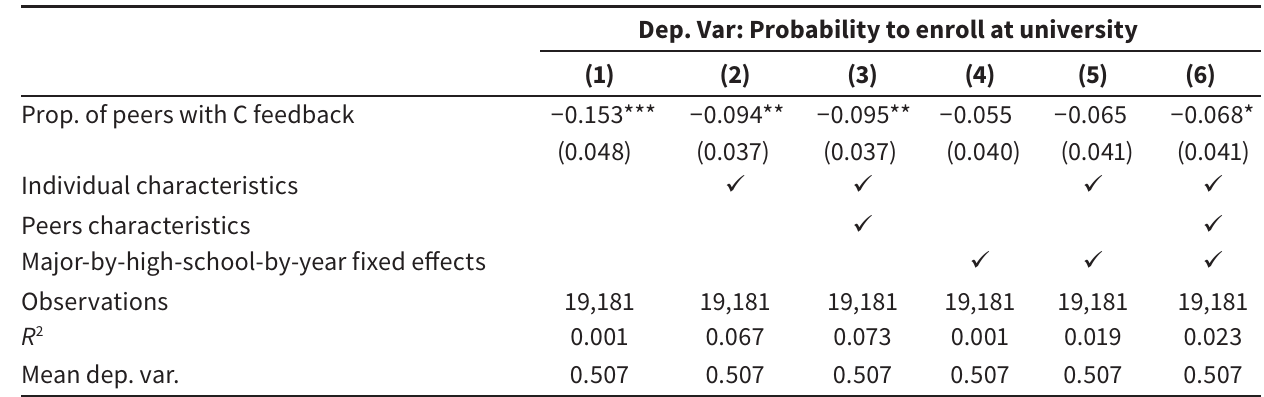
Notes : The table indicates the regression of individual enrollment on the proportion of peers with C feedback. The table reports regressions using the share of peers with C feedback as the main explanatory variable. Individual and peer mean characteristics used as control are: age, gender, a dummy for low social background, mean numerical grade, optional classes, having been academically held back, French nationality, public high school, and year dummy variables. Robust standard errors clustered at school-major-year level are reported in